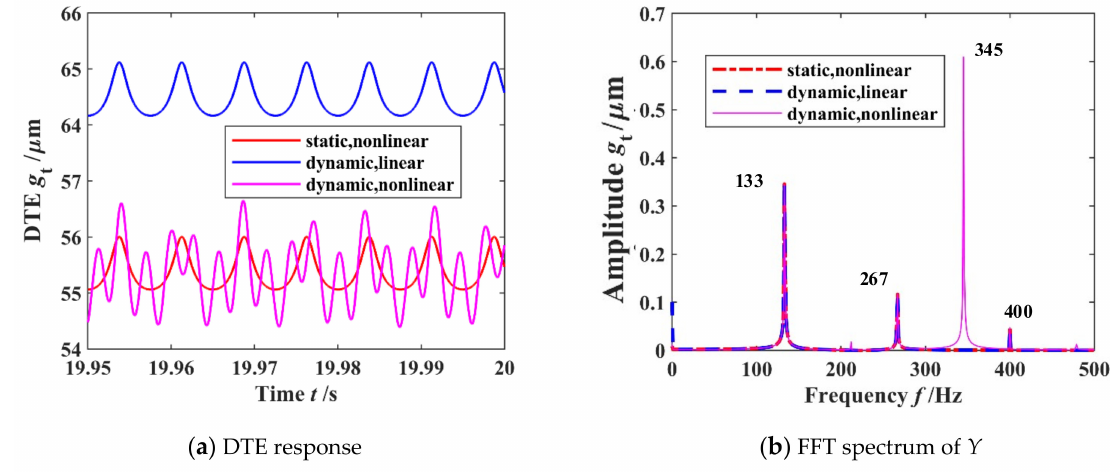
Figure 7. DTE response in time-domain and frequency-domain.